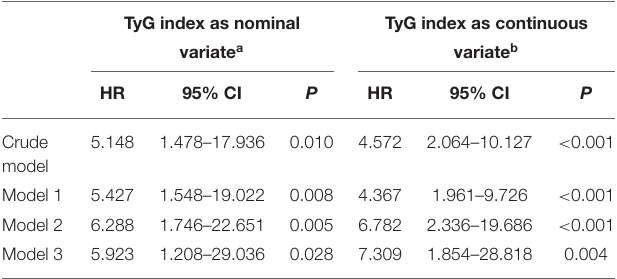
Model 1: adjusted for age and gender. Model 2: adjusted for Model 1 and hypertension, diabetes mellitus, cardiovascular disease, cerebrovascular disease, and neurological manifestations. Model 3: adjusted for Model 2 and NEU%, PLT, CD4 + T-LYM, AST, BUN, CK, and LDH. TyG, triglyceride-glucose; HR, hazard ratio. a HR was evaluated by taking the lower median of TyG index as reference. b HR was evaluated by examining 1-unit increase of TyG index.